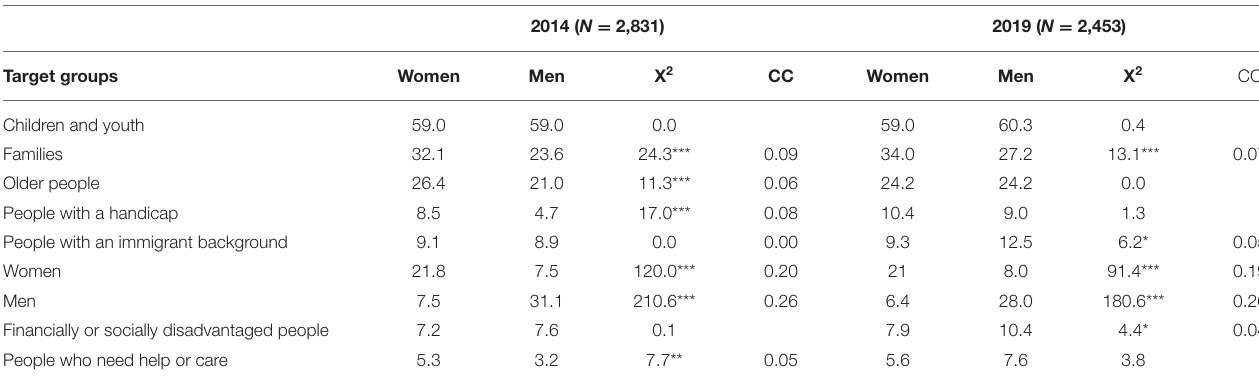
TABLE 5 | Target groups for volunteering, differentiated by gender and survey period.